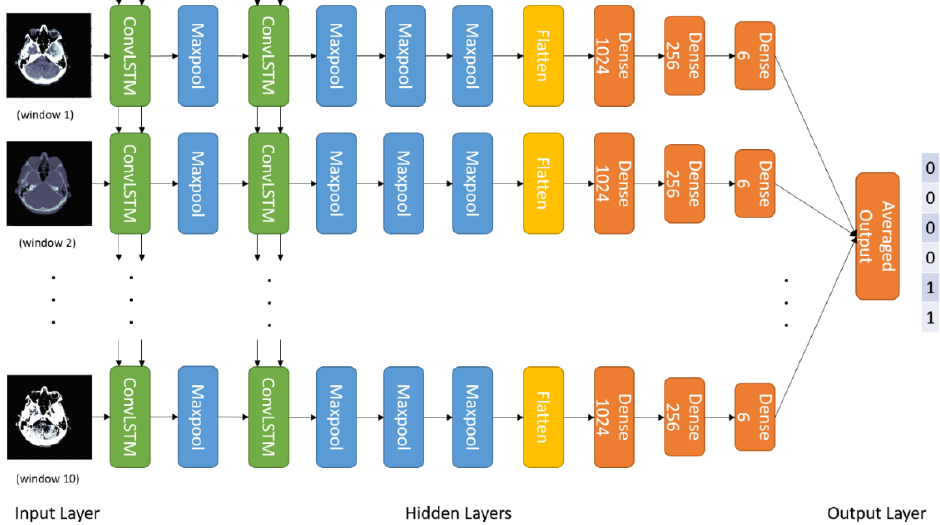
Figure 6. The architecture of the Conv-LSTM Model for ICH Detection.